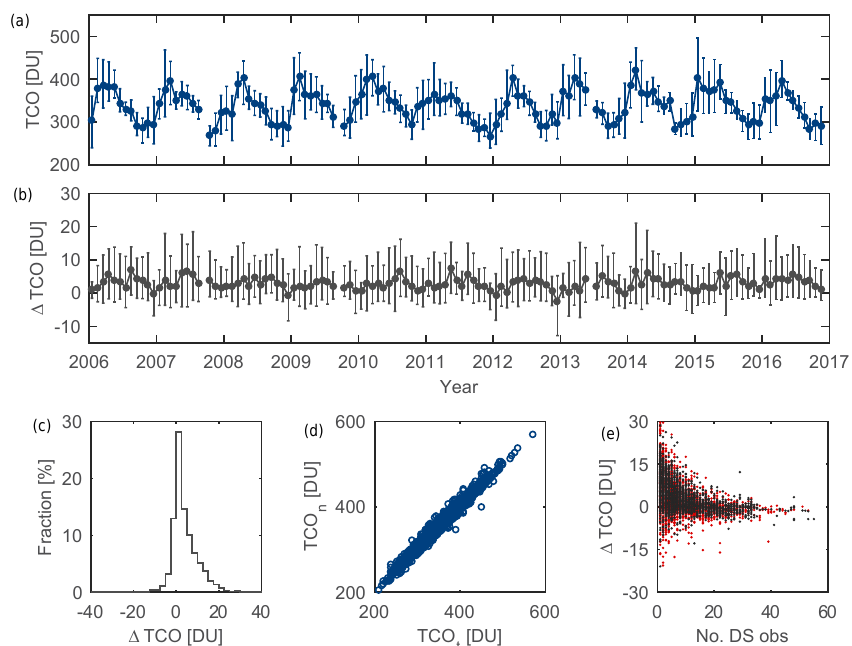
Figure 3. (a) Traditional monthly mean TCO; line length shows the upper and lower monthly 10th percentiles. (b) Mean monthly daily difference between the new and traditional best representative values plus the upper and lower monthly 10th percentiles. (c) Histogram of daily differences between traditional and new daily TCO calculations. (d) Scatterplot of new daily TCO values against the traditional TCO. (e) Scatterplot of daily difference between the new and traditional BRDV against the number of contributing DS measurements; dark grey markers are for data points from months JJASON, red markers are from the